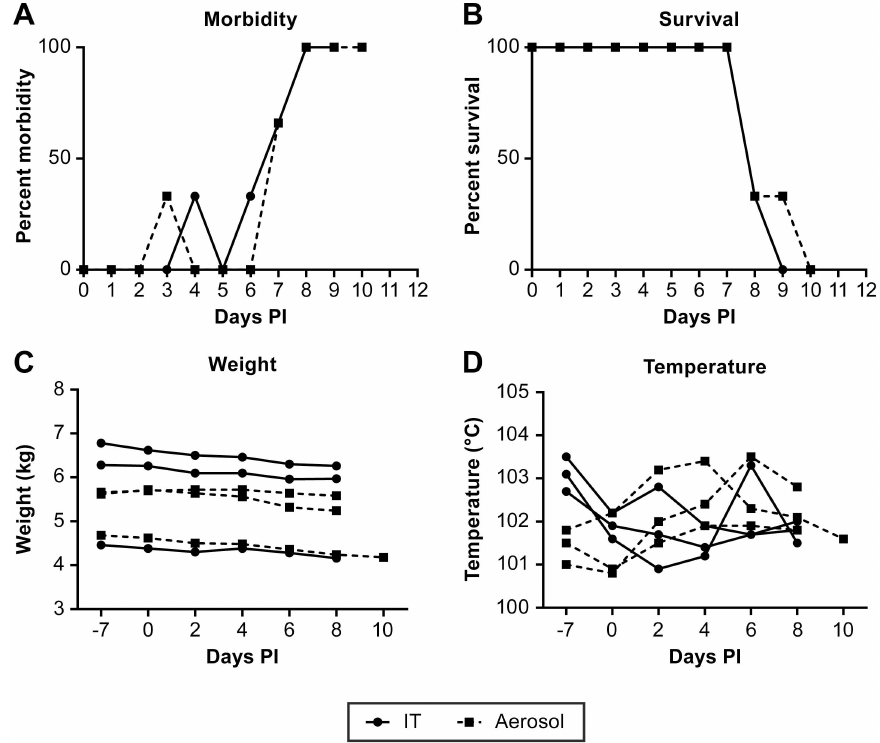
Fig 1. Clinical assessmentof NiV infected AGMs. Assessment of animalmorbidity(A), survival (B), weight (C) and body temperature (D) of the course of diseasefollowingNiV infection. IT inoculated animals are indicatedby ( ● ) and aerosol inoculated animalsby ( ■ ). Morbidity was determined based on an animal “scoring” on a 10 –point clinical assessment scale basedon cage-sideobservations.